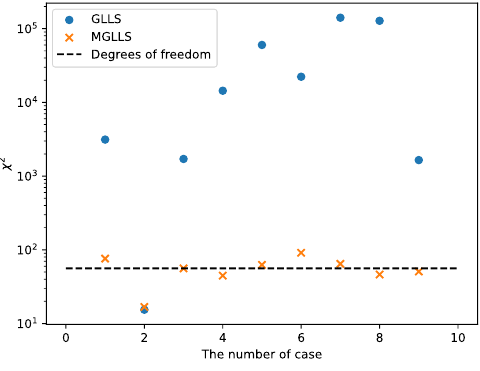
Fig. 11 Evaluated 𝝌 𝟐 value in each